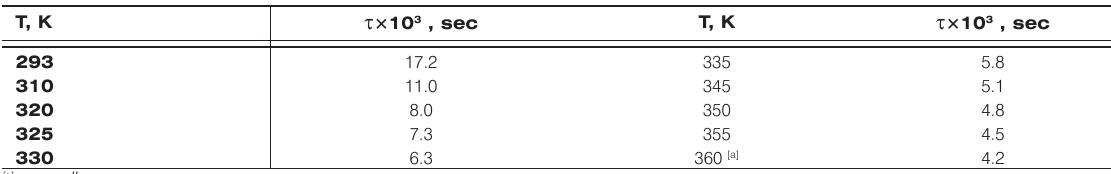
O in dioxane-d 2 8